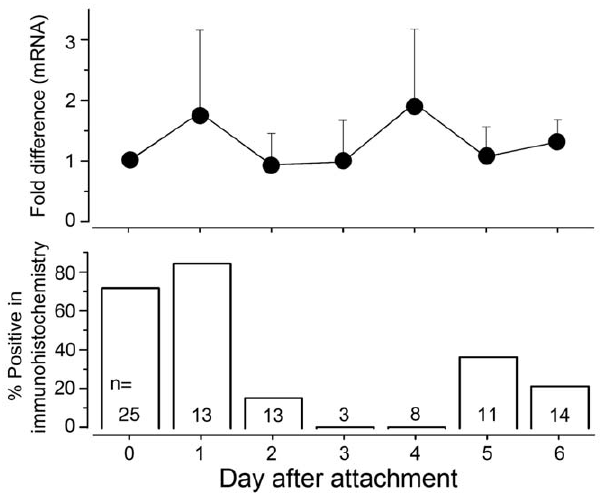
Figure 4. The levels of mRNA and protein of the D1 receptor in salivary glands. Quantitative RT-PCR showing the transcript levels of the D1 (upper panel) and the percent positive responses in the D1 immunohistochemistry (lower panel) are presented for females salivary glands fed for 6 days. The quantitative RT-PCR shows the averages and standard deviations of three biological replications.